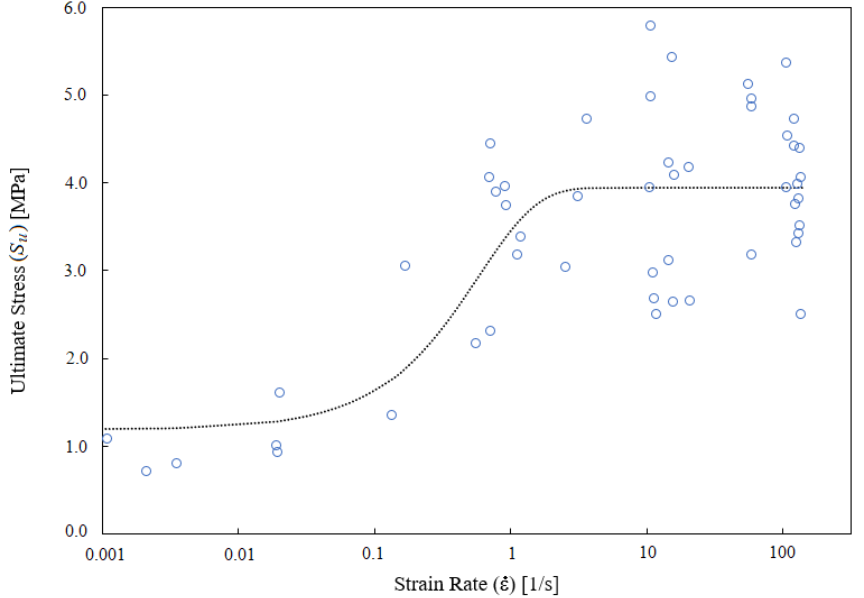
Figure 2. The nonlinear relation of ultimate stress and strain rate, for higher values of strain-rate ˙ ε > 10 s − 1 the ultimate stress seems independent of the strain rate. The SRDF ϕ ( ˙ ε ) is proportional to the black dotted